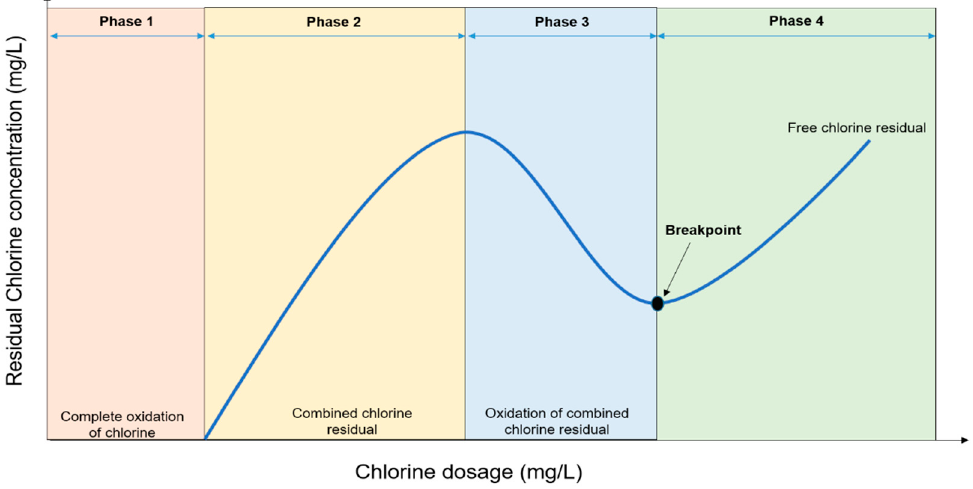
Figure 2. Graphical representation of breakpoint chlorination.